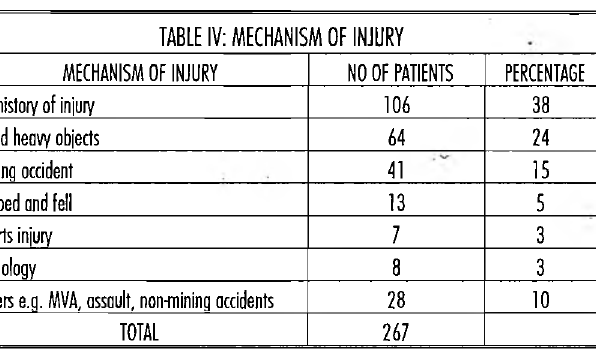
TABLE IV: MECHANISM OF INJURY MECHANISM OF INJURY NO OF